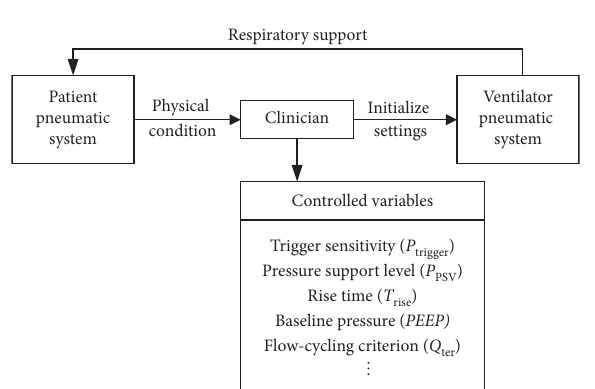
Figure 3: Clinical operation process of the mechanical ventilation.